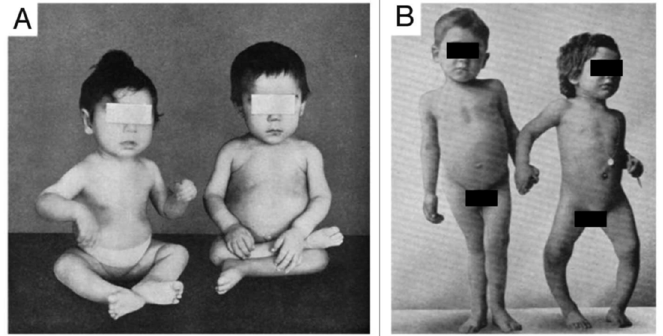
Figure 2. Skeletal deformities observed in rickets. ( A ) Photograph from the 1930s of a sister (left) and brother (right), aged 10 mo and 2.5 y, respectively, showing enlargement of the ends of the bones at the wrist, carpopedal spasm, and a typical “Taylorwise” posture of rickets. ( B ) The same brother and sister 4 y later, with classic knock knees (genu valgum) and bowed legs (genu varum), growth retardation, and other skeletal deformities. Ref. [7] Holick, copyright 2006. Reproduced with permission.